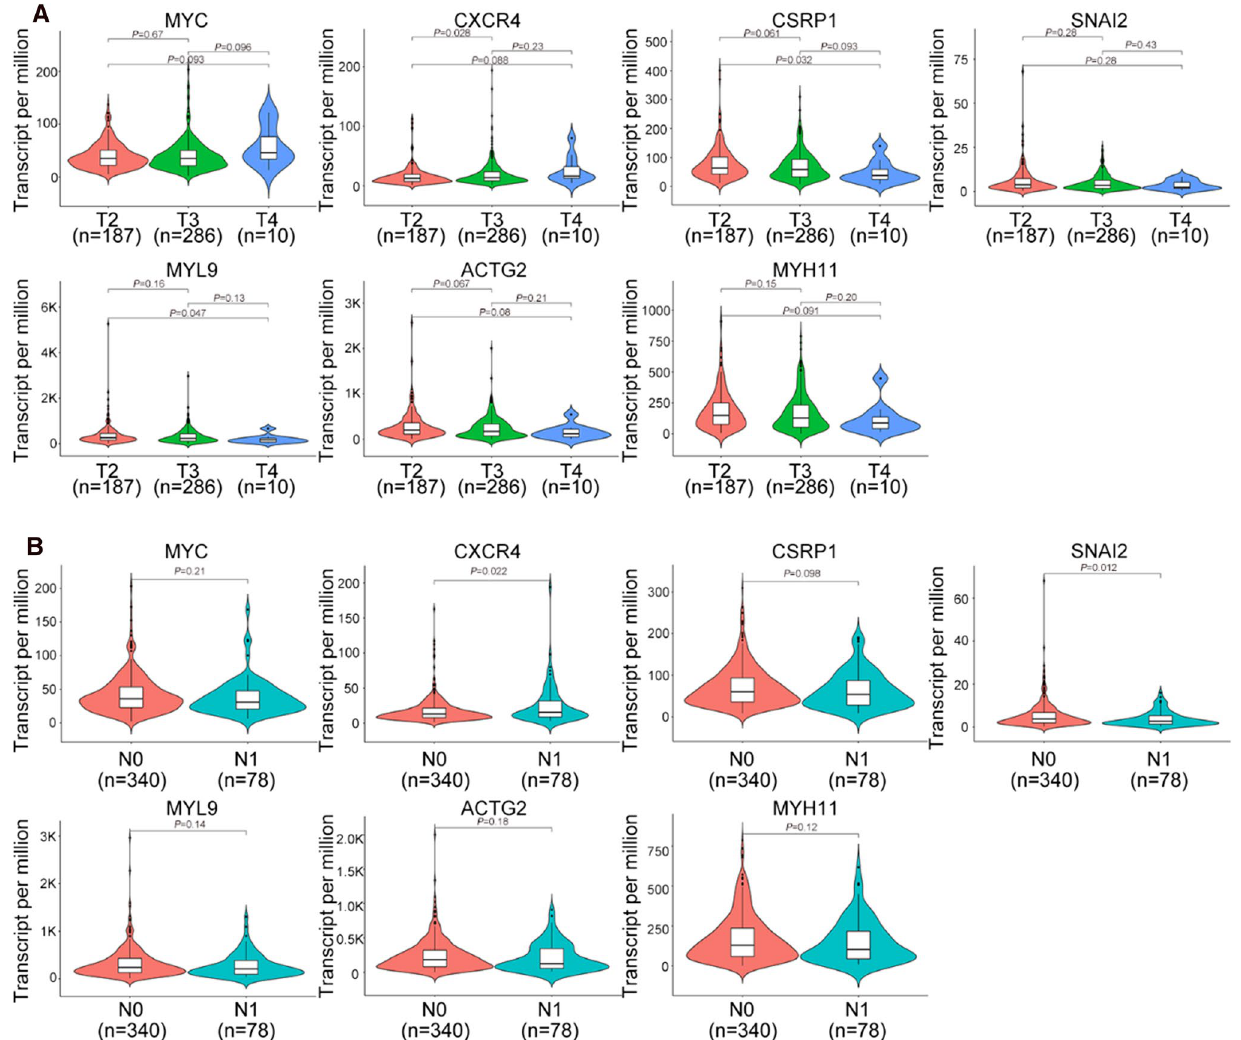
Fig. 5 The expression of hub genes in different tumor stages depend on TCGA data. A The expression of hub genes in different Tumor (T) stage depend on TNM classification of malignant tumors. B The expression of hub genes in different Node (N) stage depend on TNM clas- sification of malignant